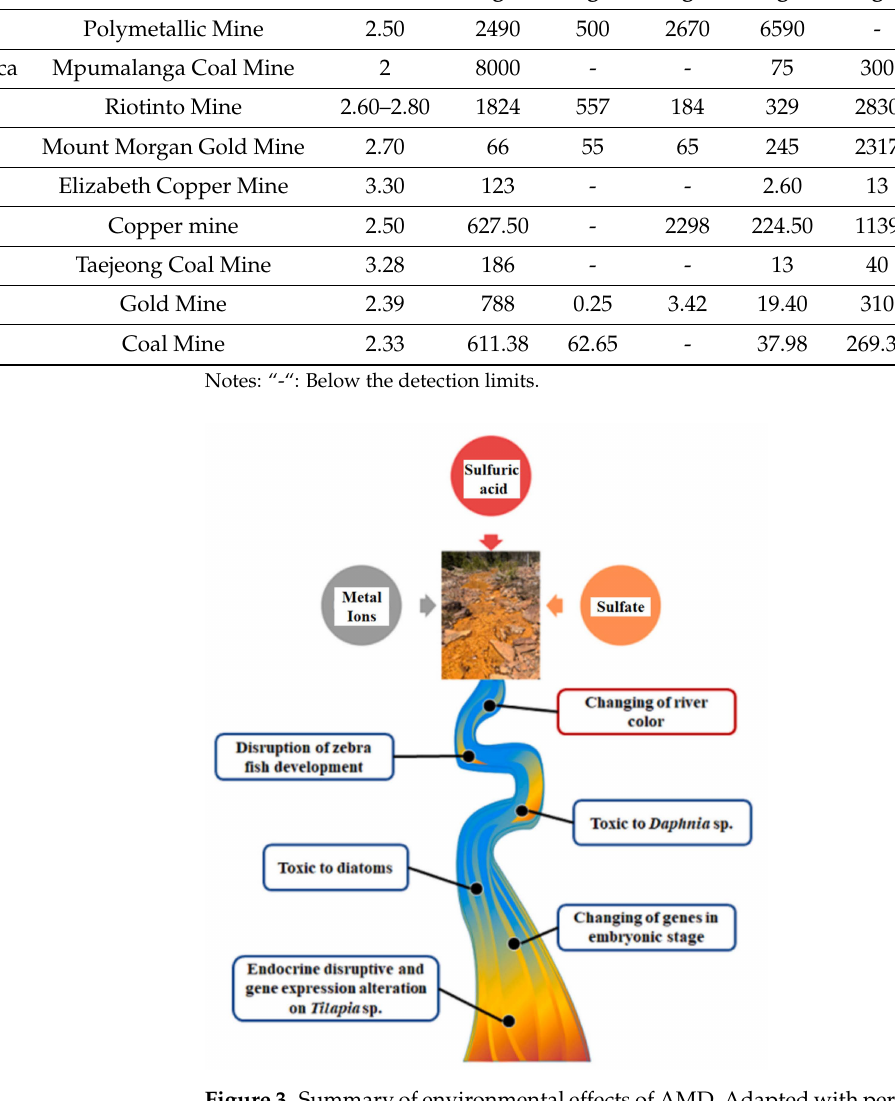
Figure 3. Summary of environmental effects of AMD. Adapted with permission from [50], copyrighter Elsevier, year